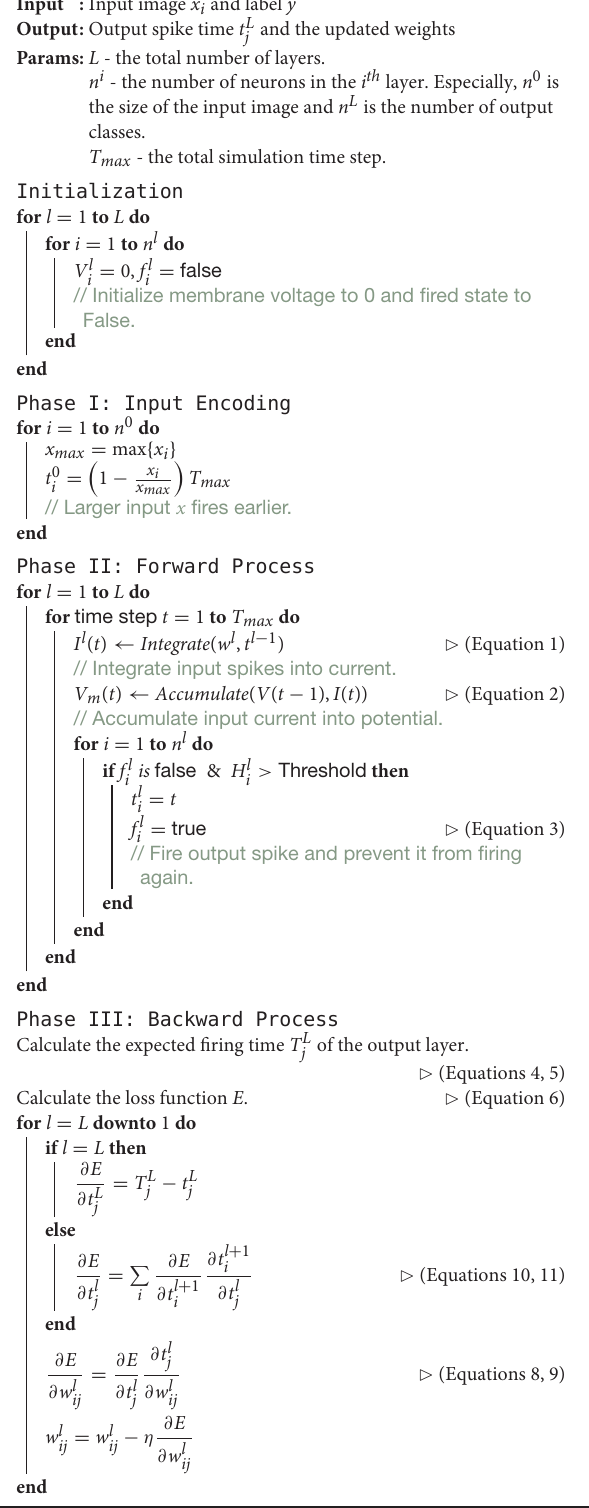
Algorithm 1: Time-based backpropagation with